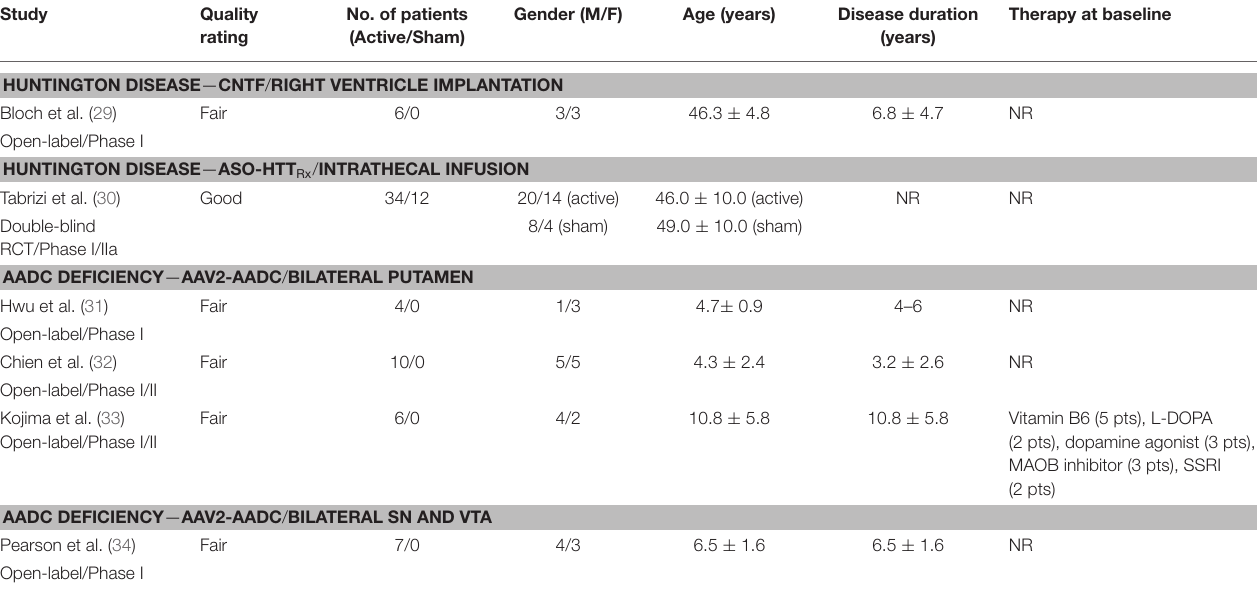
TABLE 2 | Reviewed articles—baseline features—other diseases. Study Quality No. of patients Gender (M/F) Age (years) Disease duration rating (Active/Sham)